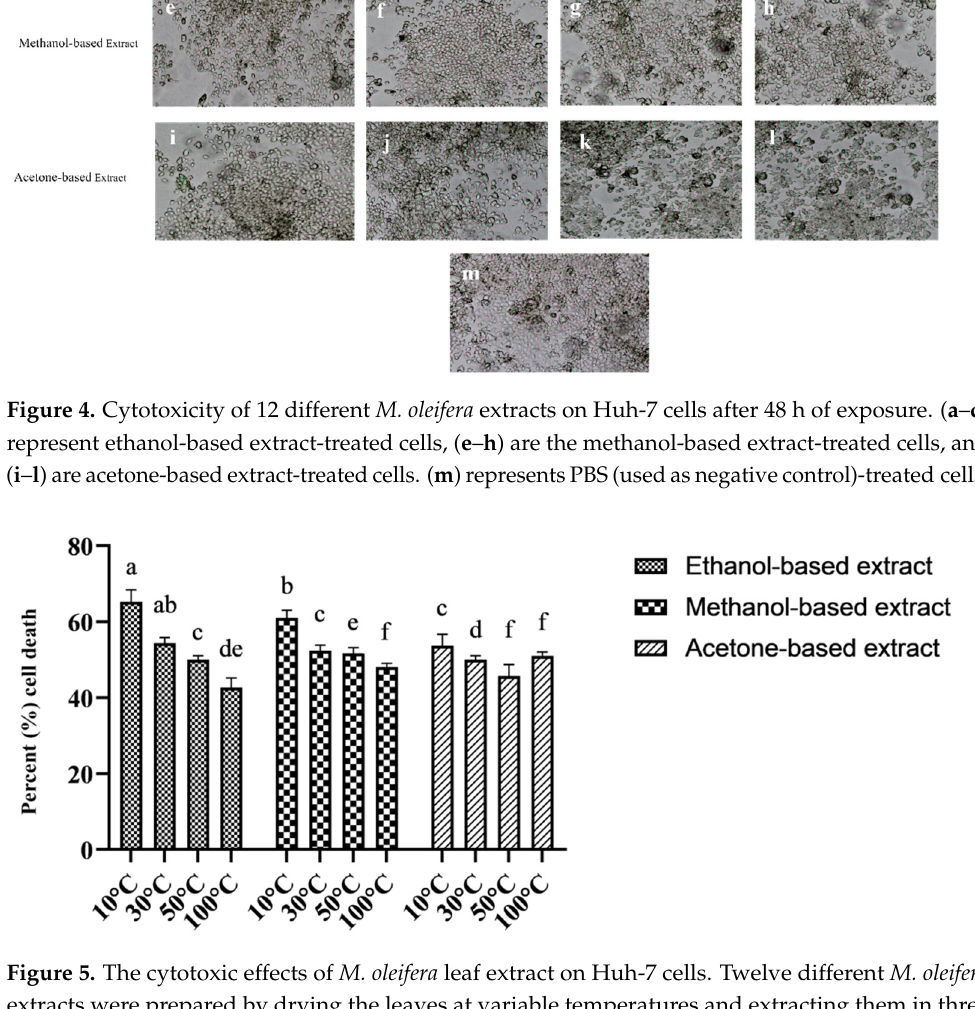
Figure 5. The cytotoxic effects of M. oleifera leaf extract on Huh-7 cells. Twelve different M. oleifera extracts were prepared by drying the leaves at variable temperatures and extracting them in three different solvents. Extracts were tested at 0.1 mg/mL. The data are expressed as the percent cell death of Huh-7 cells after treatment with plant extracts. Bars displayed the mean ± standard deviation. Significant variations ( p < 0.05) among all extracts are represented by different letters (a–f) above the bars.